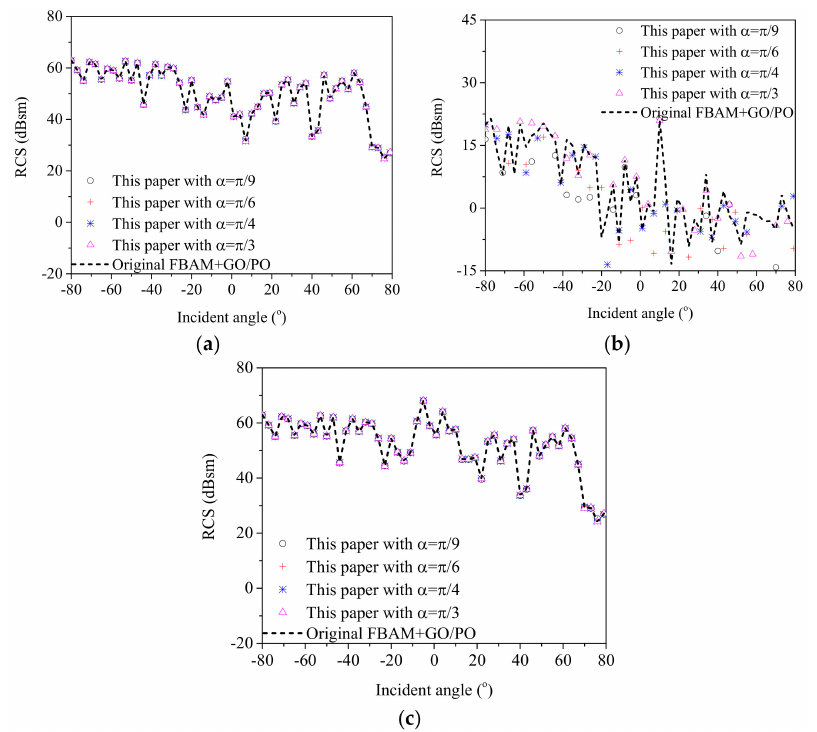
Figure 7. Comparison of calculation accuracy between the proposed way and the original GO / PO method. ( a ) The scattering filed from the ship target. ( b ) The coupling scattering field. ( c ) The total scattering